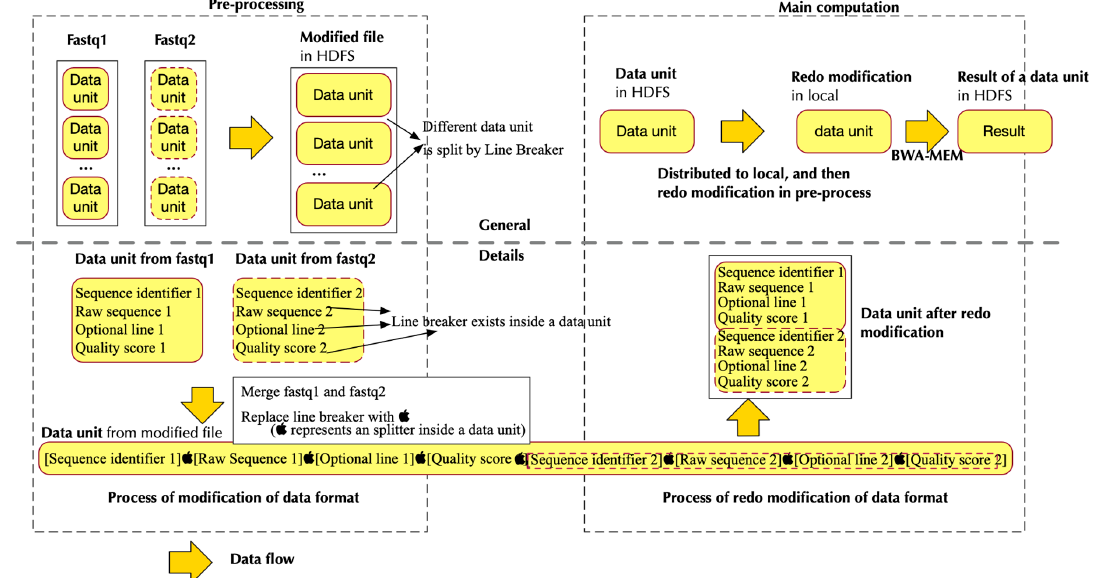
Figure 3. Data flow in PipeMEM in the paired-end situation. The upper part explains the process of